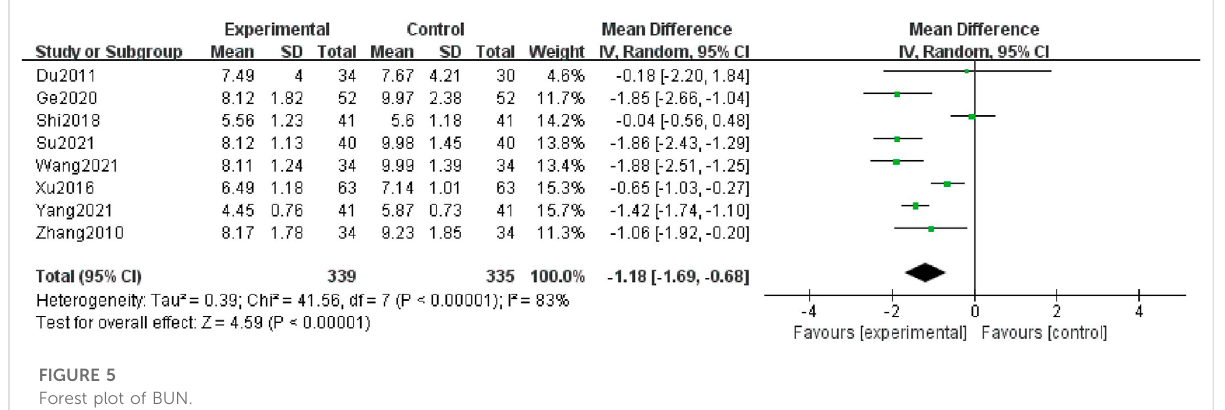
FIGURE 5 Forest plot of BUN.